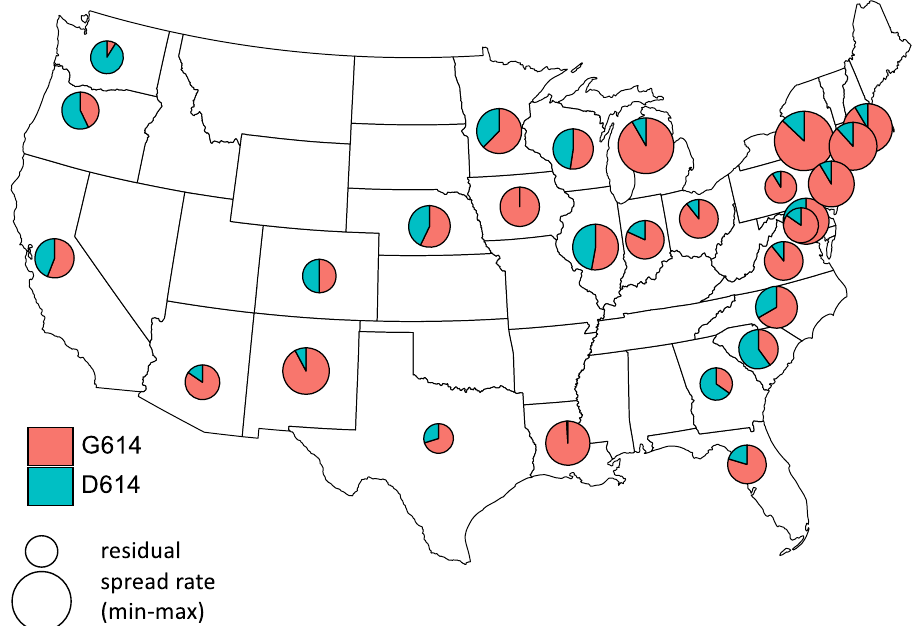
Fig. 3 Spatial distribution of strains of SARS-CoV-2 having the G614 mutation in the spike gene at the outbreak onset among states. Pie charts give the proportion of samples in states collected within 30 days following the outbreak onset that are in the G clades (red) 27 . The size of the pie is proportional to the residual values of r 0 after removing the effects of the timing of outbreak onset, population size represented by the time series, and population density. For each state, we used the estimate of r 0 corresponding to the county or county-aggregate that had the greatest number of deaths.